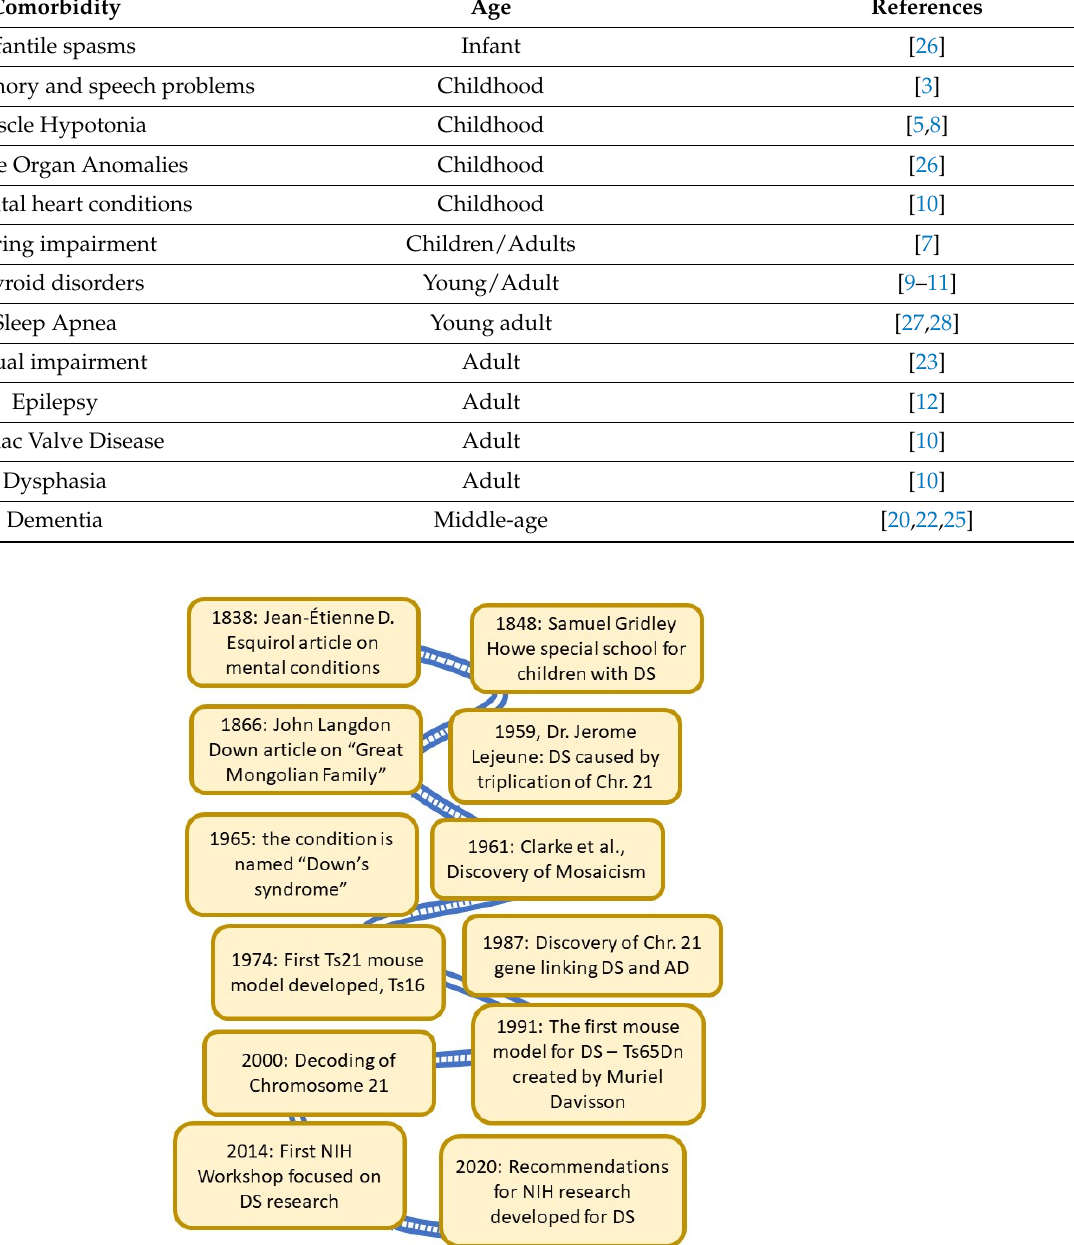
Table 1. Common age-associated morbidities in children and adults with DS. These are organized by age and sample citations provided.